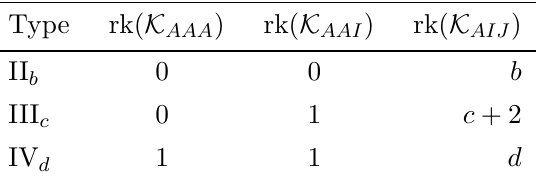
Table 2 . We list the singularity types arising in the large volume regime, when sending a single coordinate t A i . Note that the ranks rk( → ∞ whether and are vanishing or K AAA K AAI